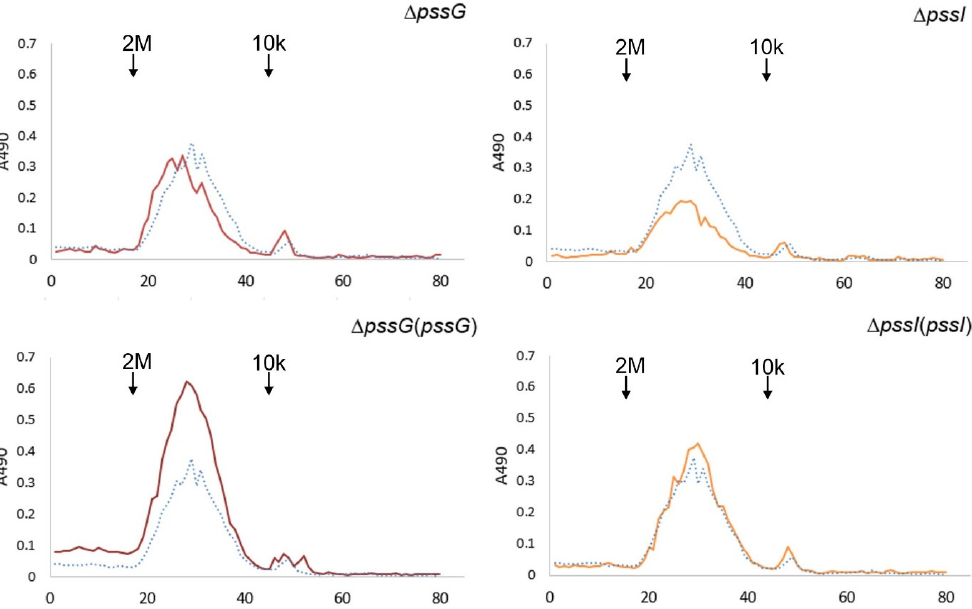
Figure 11. Gel permeation chromatography of exopolysaccharides produced by the wild-type strain RtTA1, mutants, and complementants for the pssG and pssI genes. Exopolysaccharides were precipitated with 95% ethanol from the culture supernatants. Dotted line—RtTA1, solid line—mutant or complementant indicated in the title. Molecular mass standards: 2 MDa, blue dextran, and 10 kDa, Dextran T10. In the case of the pssI gene, a complemented derivative ∆ pssI ( pssI -lc) was analyzed.